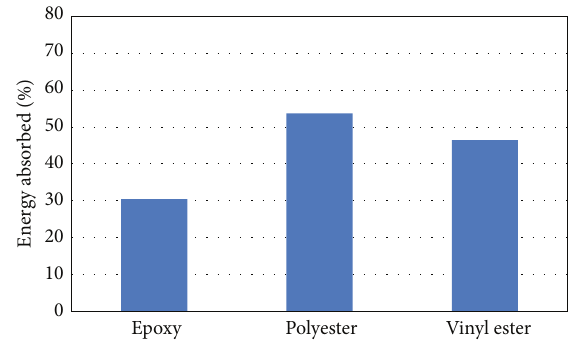
Figure 7: Impact strength of three composites at 0 ∘ /90 ∘ orientation.